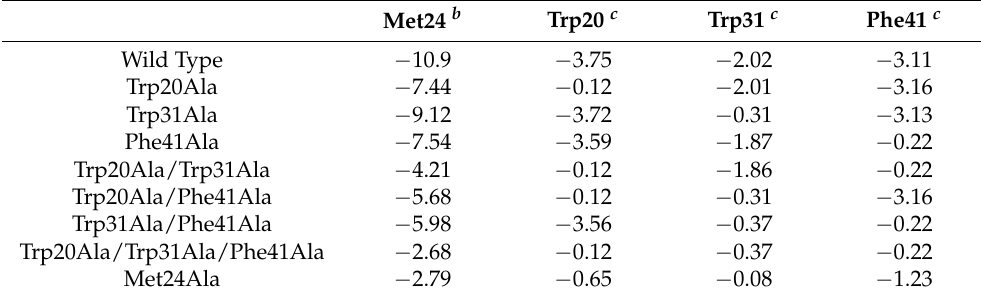
a Energies in kcal mol − 1 . b Net interaction energy (side chain versus side chain). c Pairwise sidechain to sidechain interaction energy with the residue at position